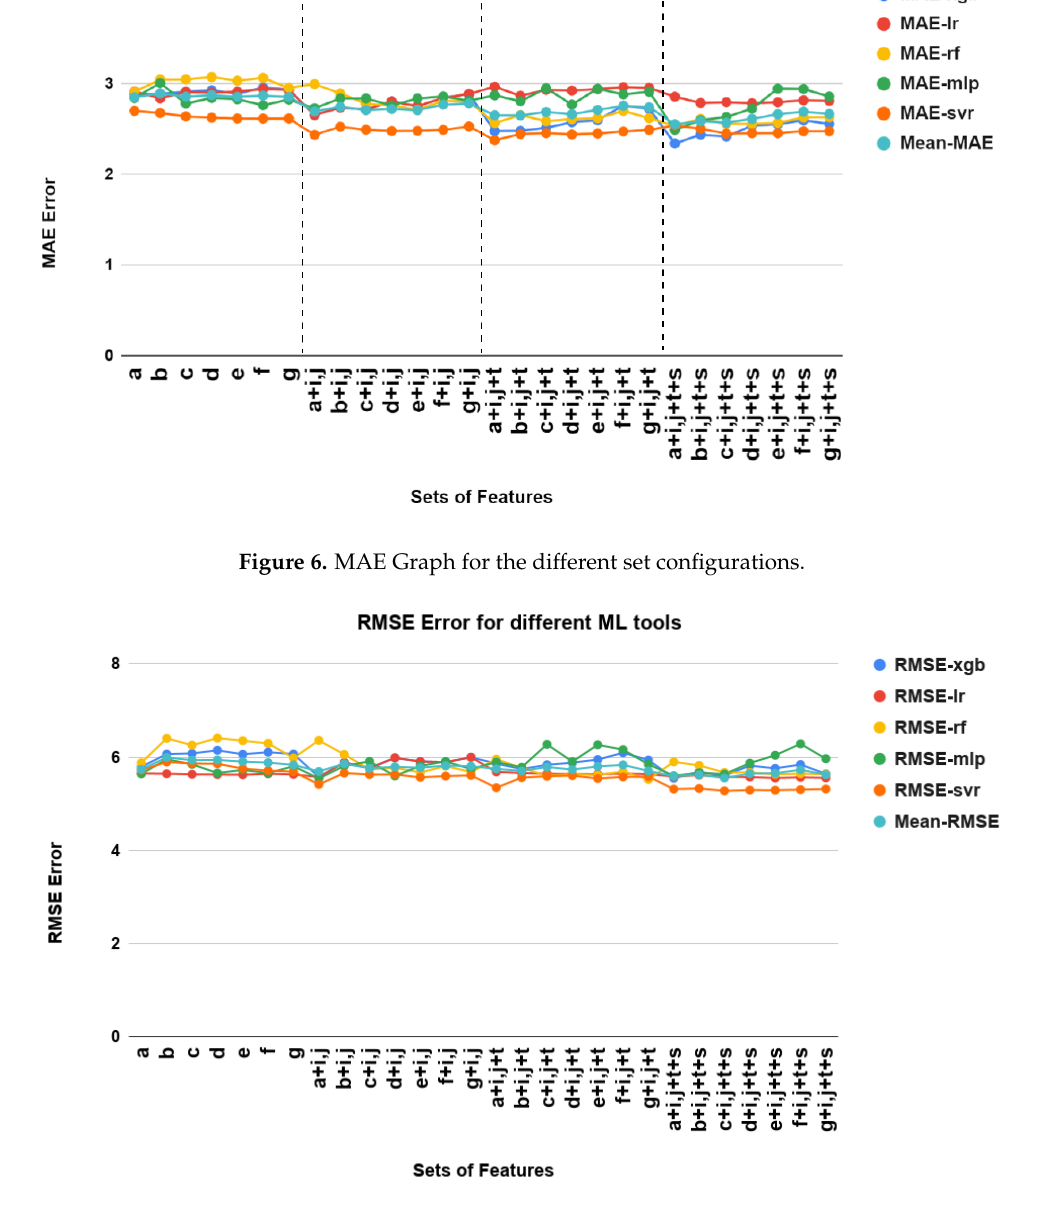
Figure 7. RMSE Graph for the different set